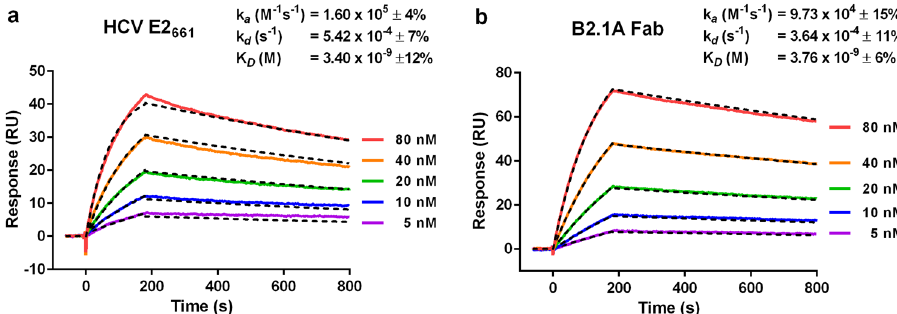
Fig. 3 Af fi nity of HCV E2 661 and B2.1 A Fab for AP33. SPR sensorgrams showing the binding to and subsequent dissociation from immobilized AP33 of ( a ) monomeric E2 661 and ( b ) B2.1 A Fab at fi ve concentrations (5 nM to 80 nM). Biacore X100 Evaluation software was used to obtain kinetic af fi nity constants by fi tting a 1:1 binding model (dashed black lines). The kinetic constants shown are the mean and SD of three independent experiments.